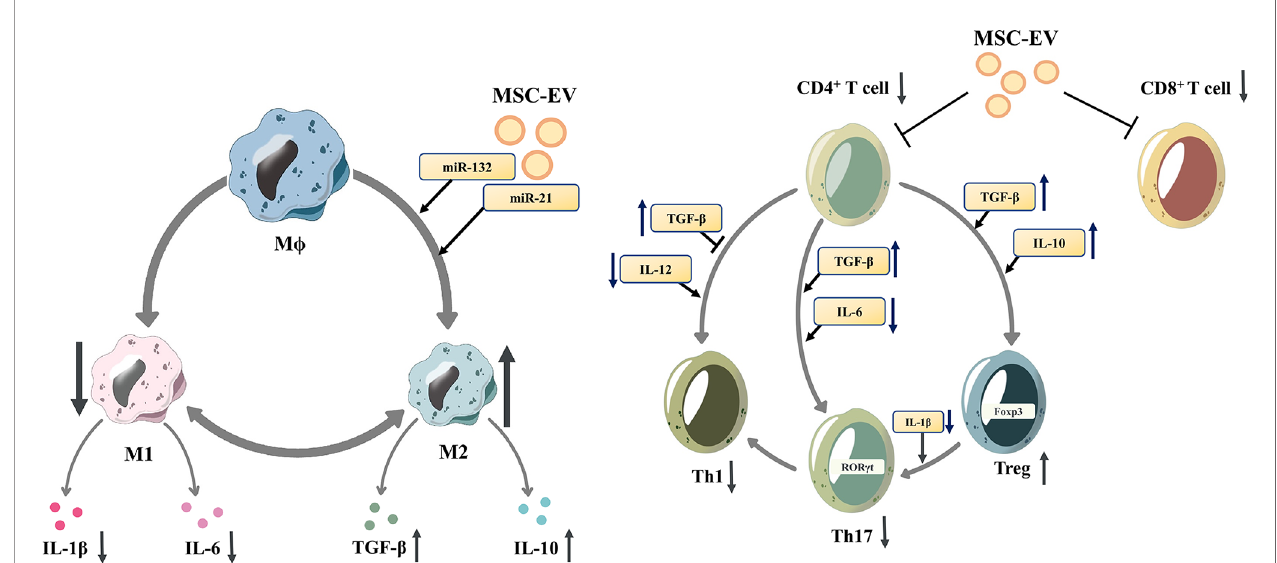
FIGURE 1 | Mesenchymal stem cell-derived extracellular vesicles modulate the differentiation of macrophages and T cells. Mesenchymal stem cell-derived extracellular vesicles (MSC-EVs)reduce the proliferation of proin fl ammatory cells (M1 macrophages, CD8+ T cells, Th1 and Th17 cells)and downregulate the release of IL-1 b and IL-6. In contrast, MSC-EVs increase the proportion of anti-in fl ammatory subtypes (M2 macrophages and Tregs), and upregulate the release of anti- in fl ammatory cytokines, such as TGF- b and IL-10. M1 macrophage, M1-polarized phenotype macrophage; M2 macrophage, M2-polarized phenotype macrophage; Th 1 cells, T helper 1 cells; Th17 cells, T helper 17 cells; Tregs, regulatory T cells; IL-1 b , Interleukin 1 b ; IL-6, Interleukin 6; TGF- b , transforming growth factor- b ; IL-10, Interleukin